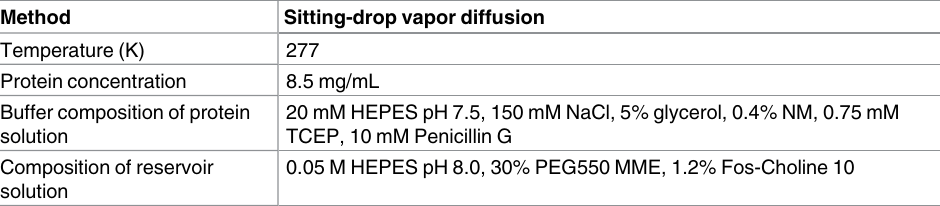
Table 1. Crystallization